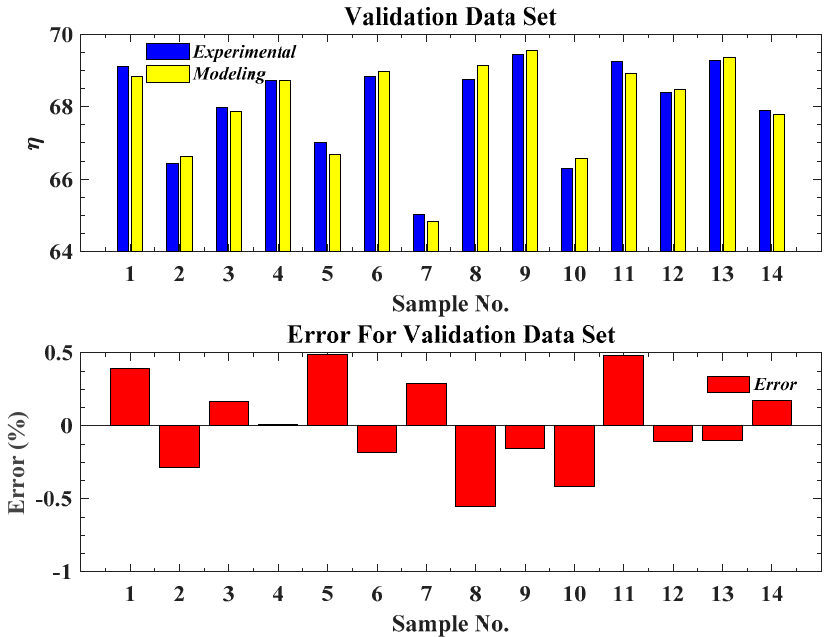
Figure 7. Comparison of experimental data and modeling for validation stage (14 data).